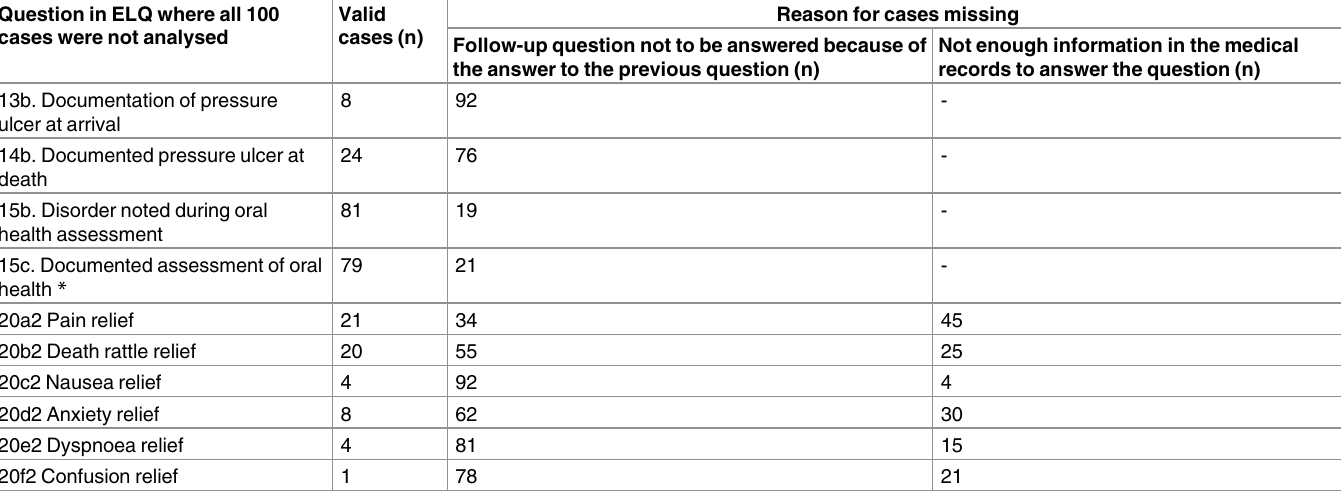
Table 3. Number of valid cases for the ELQ items where cases were missing in the comparison between ELQ registrations from the SRPC and new ELQs based on the medical records for the individual ELQ items. Question in ELQ where all 100 cases were not